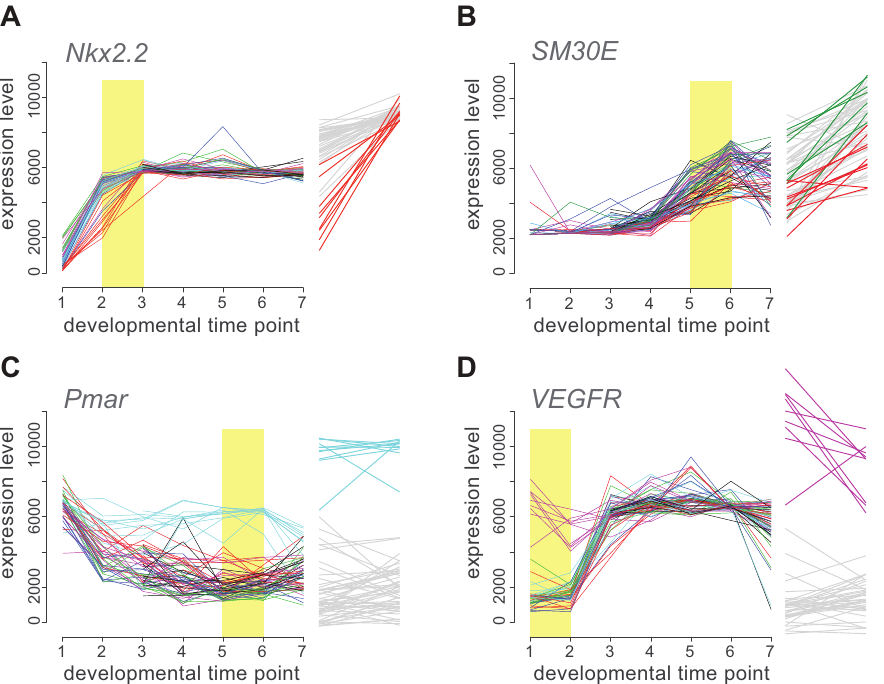
Figure 2. Parent-of-origin effects on gene expression profiles. Changes in transcript abundance across seven developmental stages are plotted for each family for four representative genes. Families are color-coded by parent of origin: dam in (A, C, D) and sire in (B). In each case, gene expression profiles in the families derived from one parent stand out as distinct from all the other families (color versus grey in magnified time segments to the right of each plot; yellow rectangles indicate magnified portion). doi:10.1371/journal.pbio.1001696.g002 (Spearman Rho = 0.87, p = 2.2 6 10 2 5 ), consistent with predomi- nately zygotic transcription after the first time point. The magnitude of parental influences on variation in gene expression clearly changed during development (Kruskal-Wallis, p =2.9 6 10 2 5 , x 2 = 61.21, df= 6) (Figures 3 and S1B), with the first two time points showing significantly greater variation in parental effects among families than later time points (mean s 2 est = 0.286